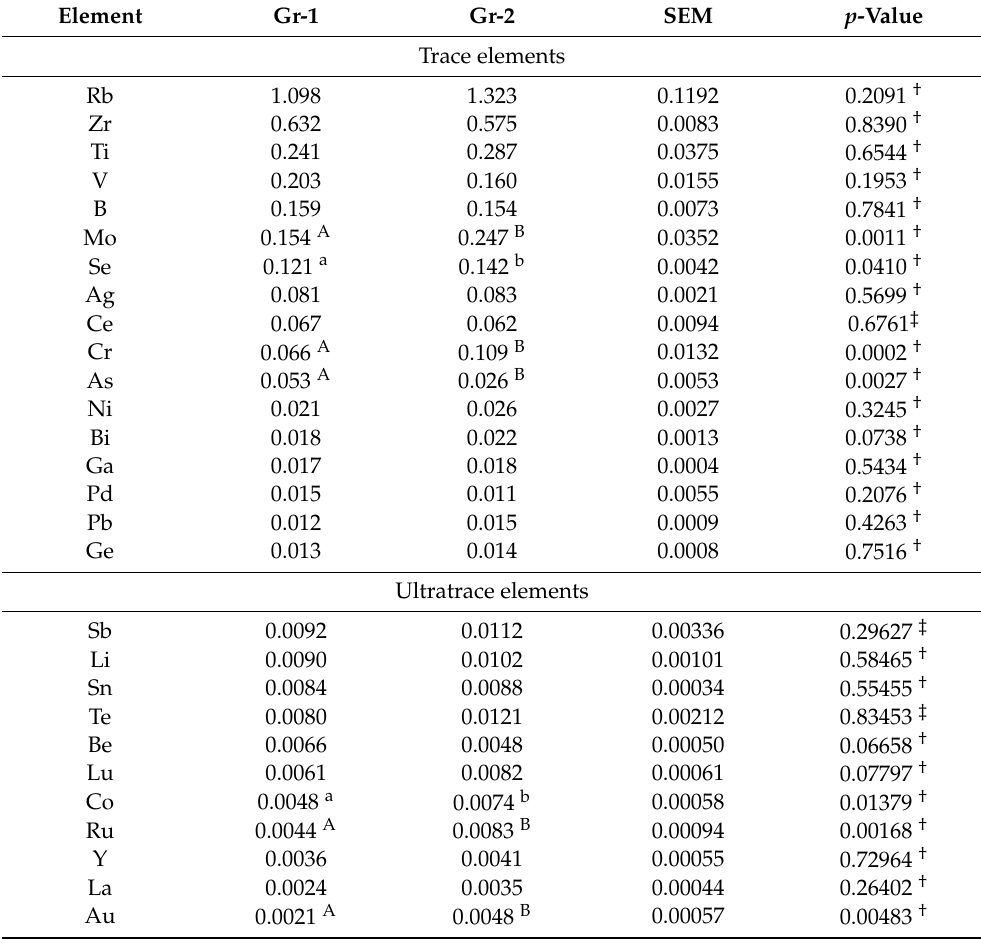
Table 6. The concentrations of trace and ultratrace elements in the egg albumen (mg/kg).